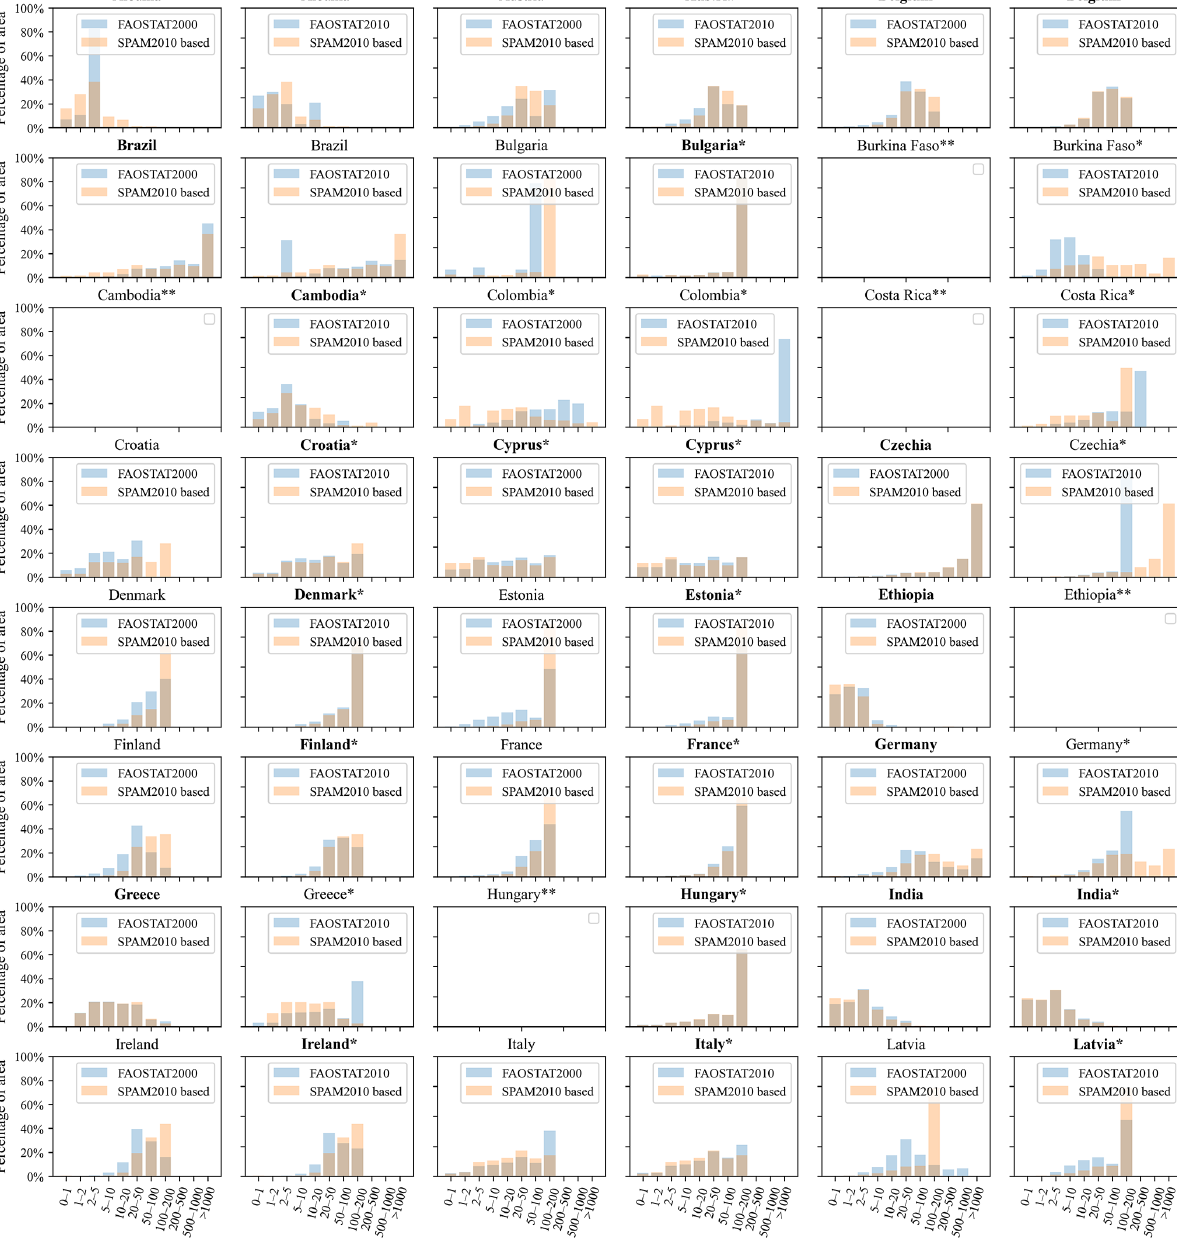
https://doi.org/10.5194/essd-14-4397-2022 Earth Syst. Sci. Data, 14, 4397–4418,